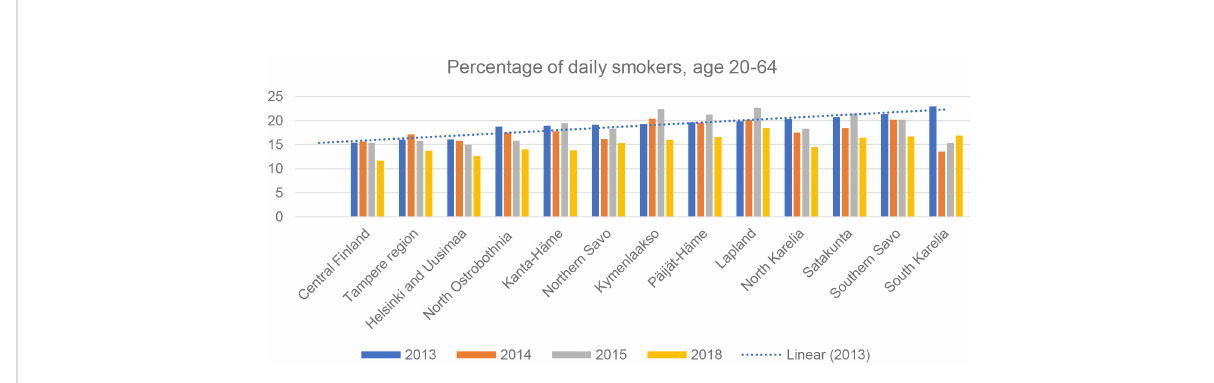
FIGURE 6 Total number of daily smokers in different hospital districts from 2013 to 2018 in